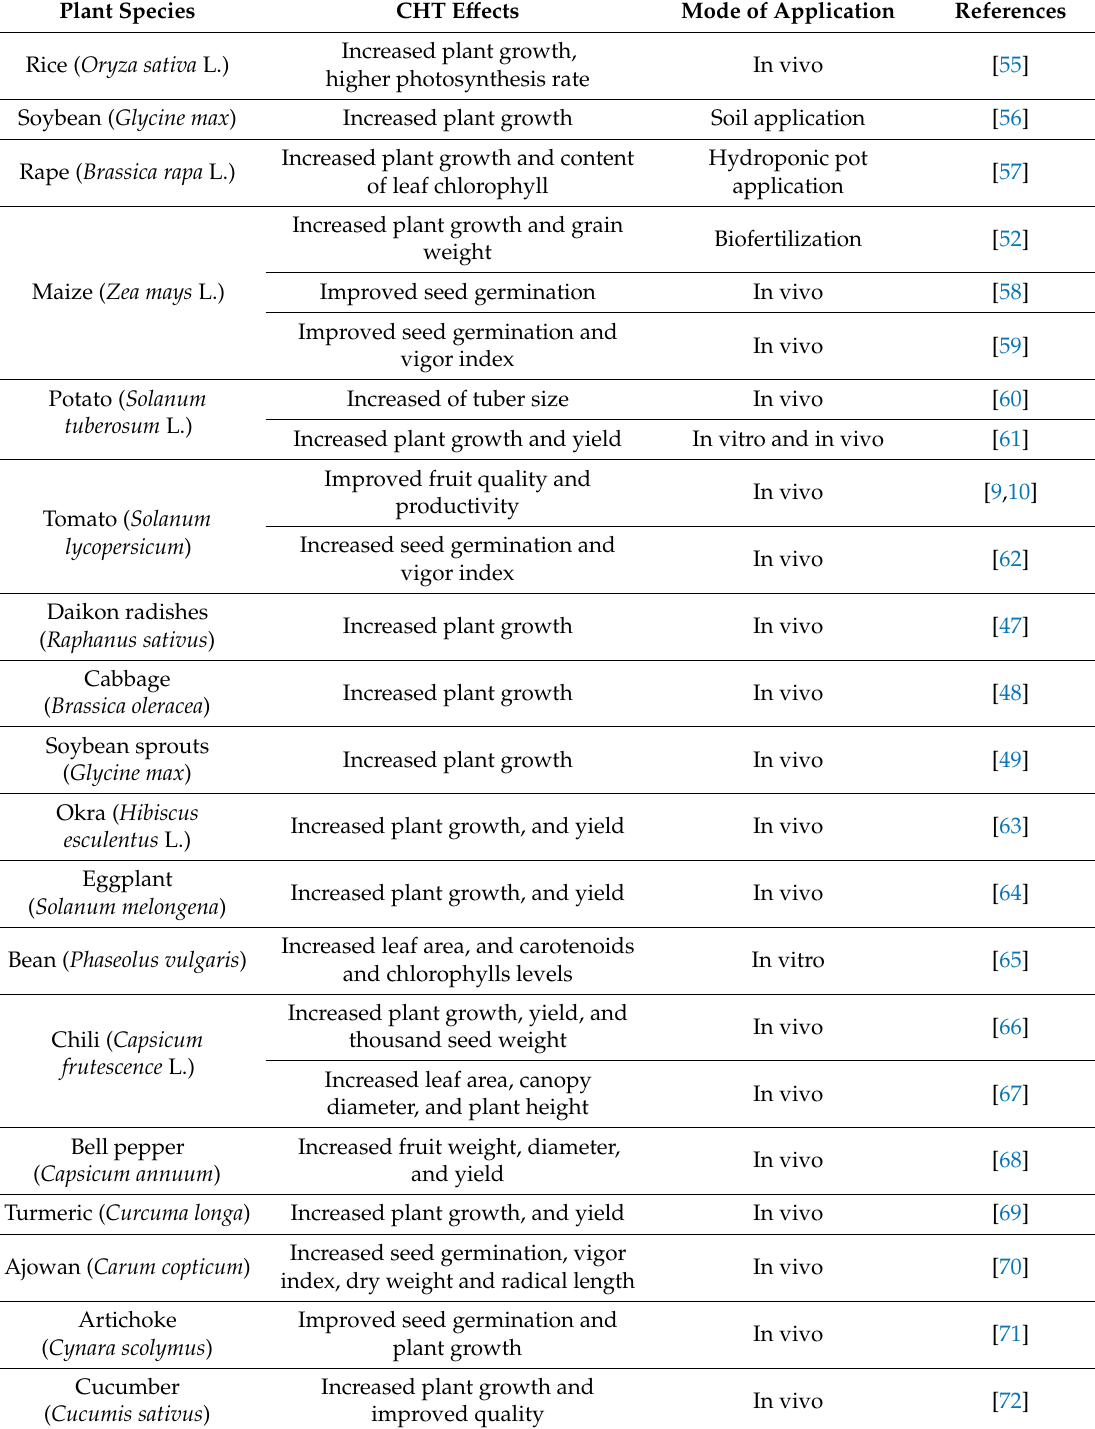
Table 1. E ff ects of chitosan (CHT) on plant growth and